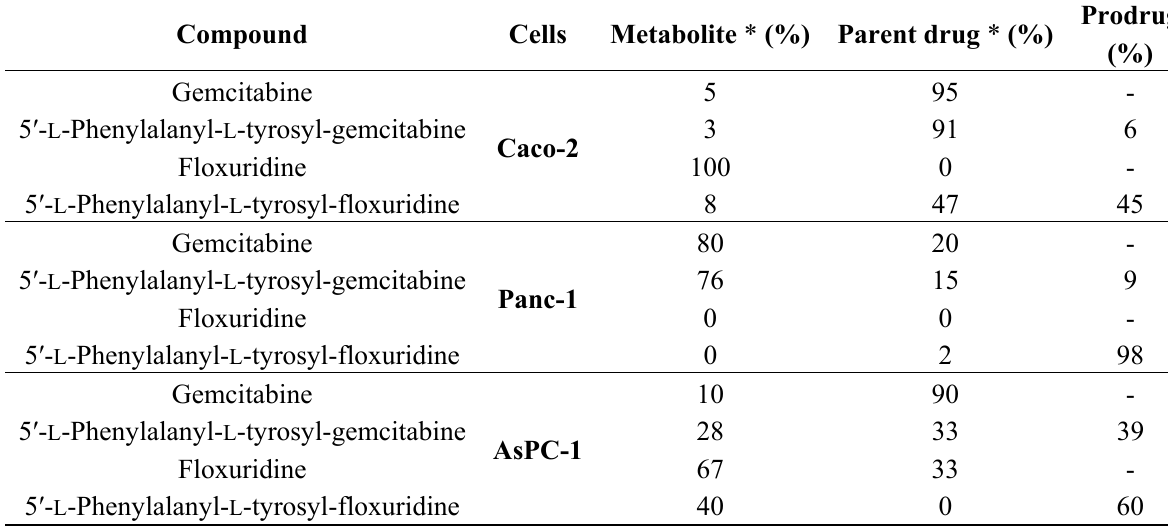
Figure 3. The uptake study with floxuridine, 5 ′ - L -phenylalanyl- L -tyrosyl-floxuridine, gemcitabine, and 5 ′ - L -phenylalanyl- L -tyrosyl-gemcitabine found in Panc-1 cells with 1 h incubation with the presence and the absence of 10 mM Gly-Pro. Each column represents the total amount of floxuridine/gemcitabine prodrug, floxuridine/gemcitabine, and 5-FU/cytosine. Data are expressed as the amount, µM/mg of protein, mean ± SD, n = 3. * p < 0.05, the uptake amount of dipeptide prodrugs is compared with their parents, floxuridine and